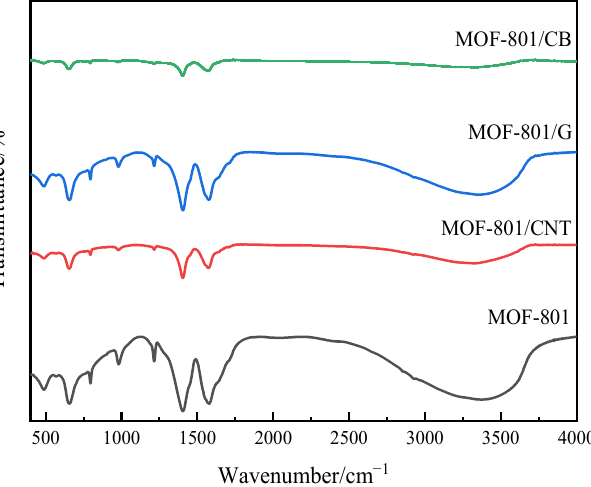
Figure 3. FTIR Image of MOF-801, MOF-801/CNT, MOF-801/G, and MOF-801/CB.